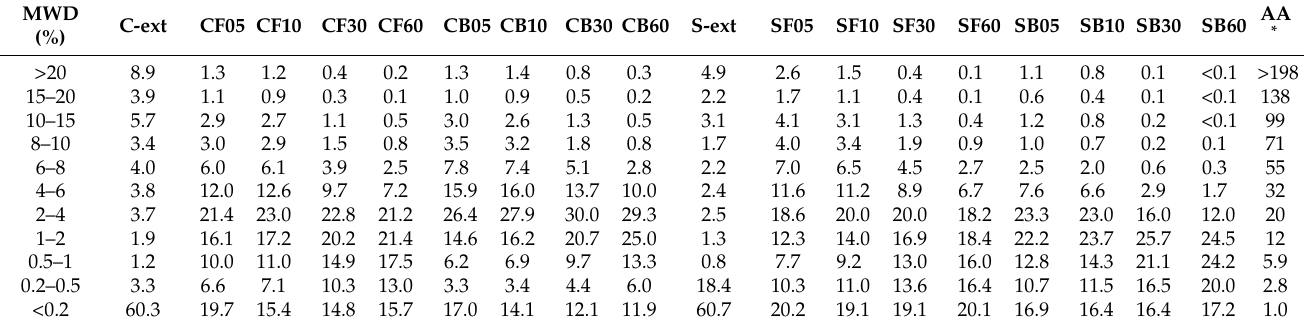
Table 2. Apparent molecular weight distribution (MWD; kDa) and average amino acid units in the molecular size of direct protein extracts (-ext) and hydrolysates made from cod (C) and salmon (S) backbones with FoodPro PNL (F) and Bromelain (B) for 5, 10, 30 and 60 min.